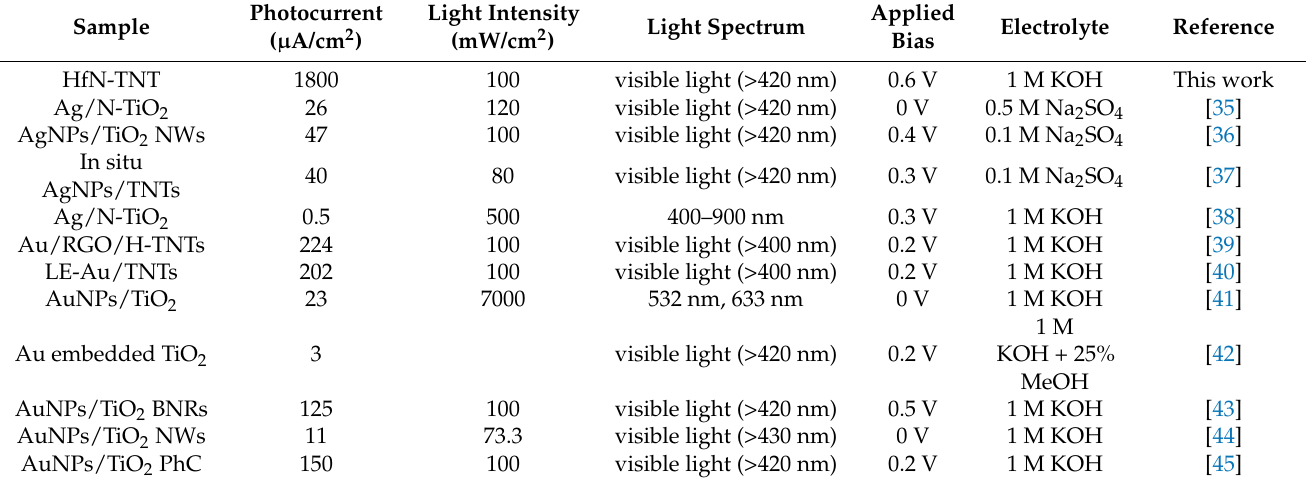
Table 1. A summary of photocurrent densities observed with plasmonic noble metal-decorated TiO 2 -based photoanodes for PEC water splitting under visible light